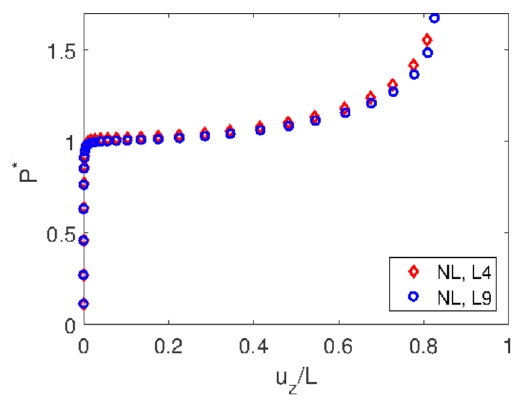
Figure 2. The equilibrium curves for L4 and L9 of isotropic box beam subjected to axial loading, P ∗ = 4 PL 2 / π 2 EI